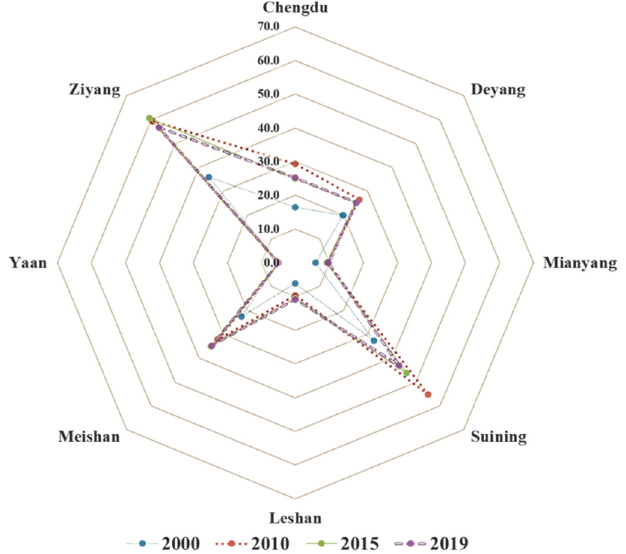
Figure 5. The EF depth of eight cities from 2000 to Figure 5. the EF depth of eight cities from 2000 to 2019.